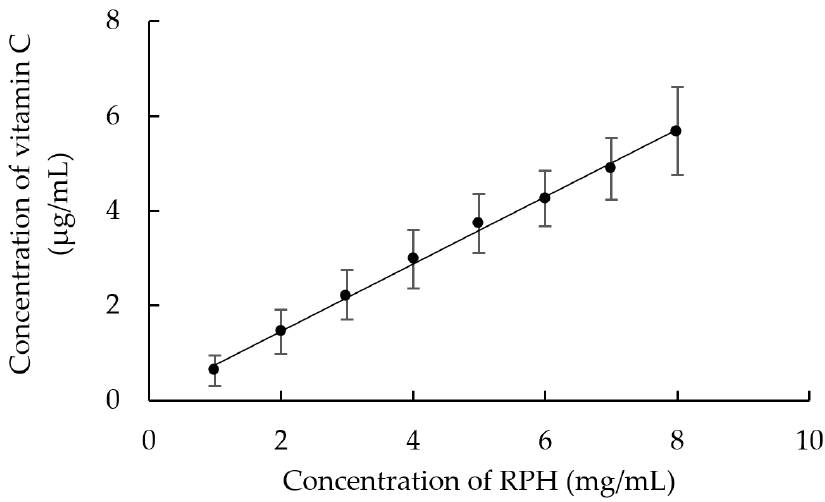
Figure 4. Influence of the concentration of RPH on reduction capacity.